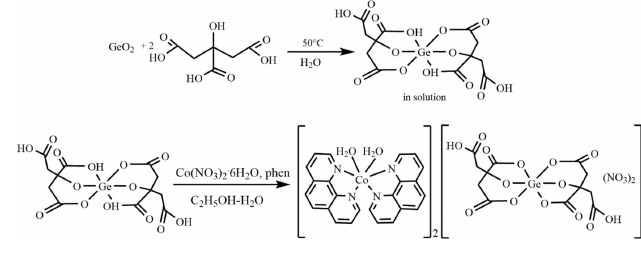
Figure 3 Two-step synthesis of [Co(H 2 O) 2 (phen) 2 ] 2 [Ge(HCit) 2 (NO 3 ) 2 ].